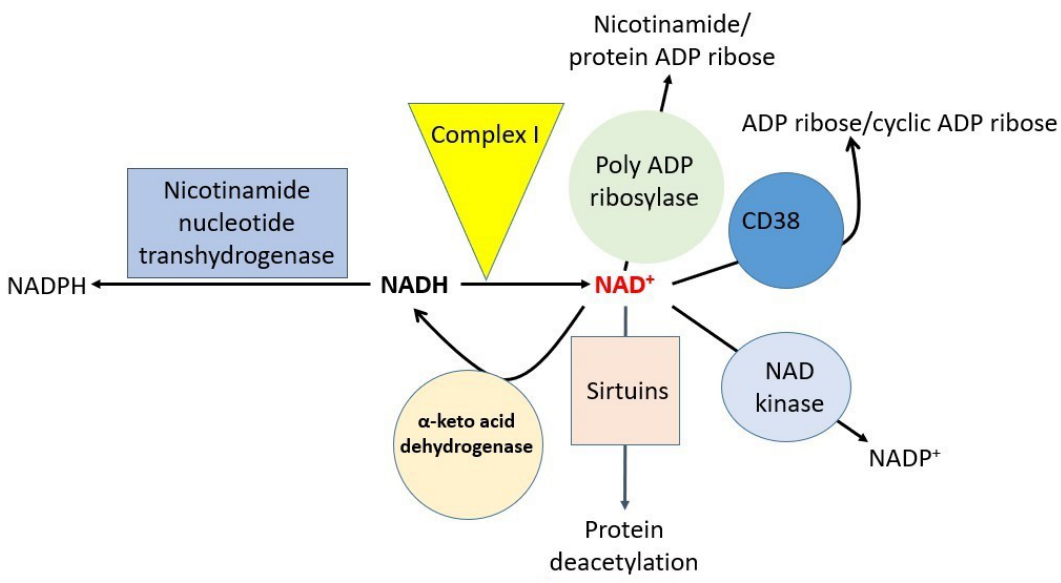
Figure 4. Major NAD-dependent redox enzymes that are potentially involved in cisplatin-induced kidney